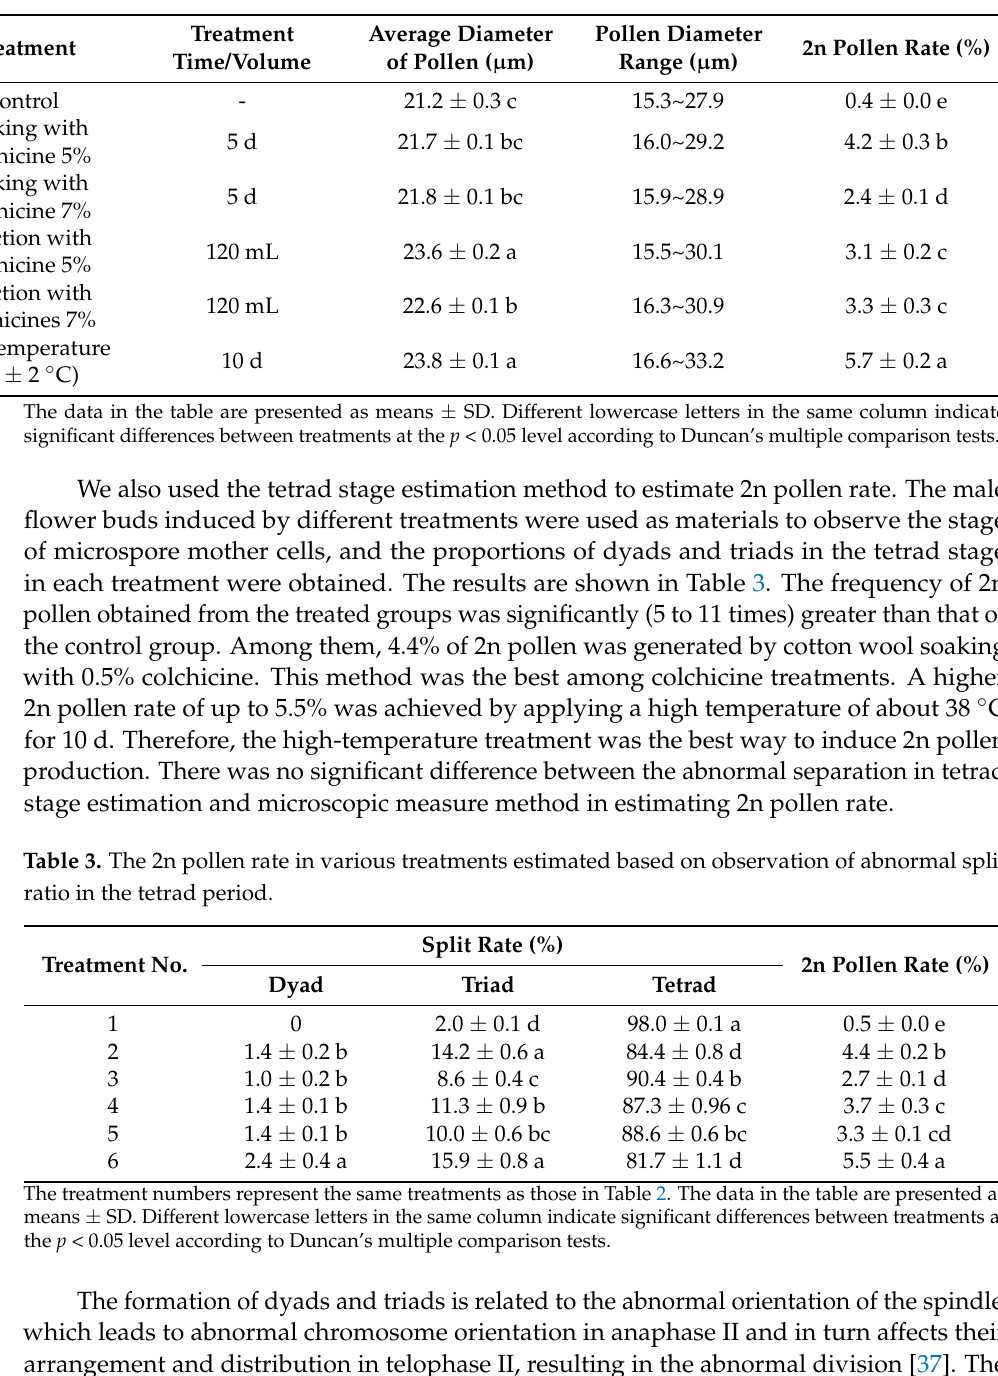
Table 2. The 2n pollen rate in various treatments estimated based on microscopic measurement.